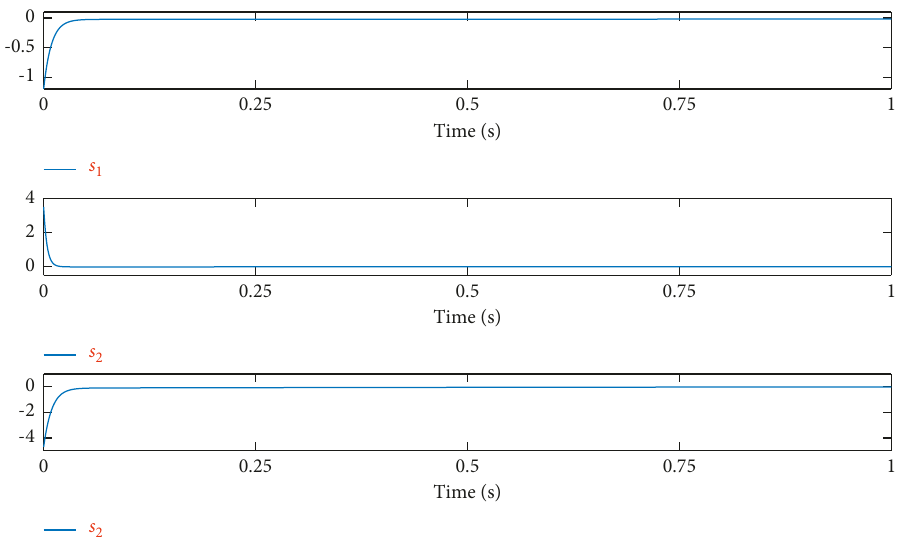
Figure 11: Scenario 6.2: synchronization error signals.